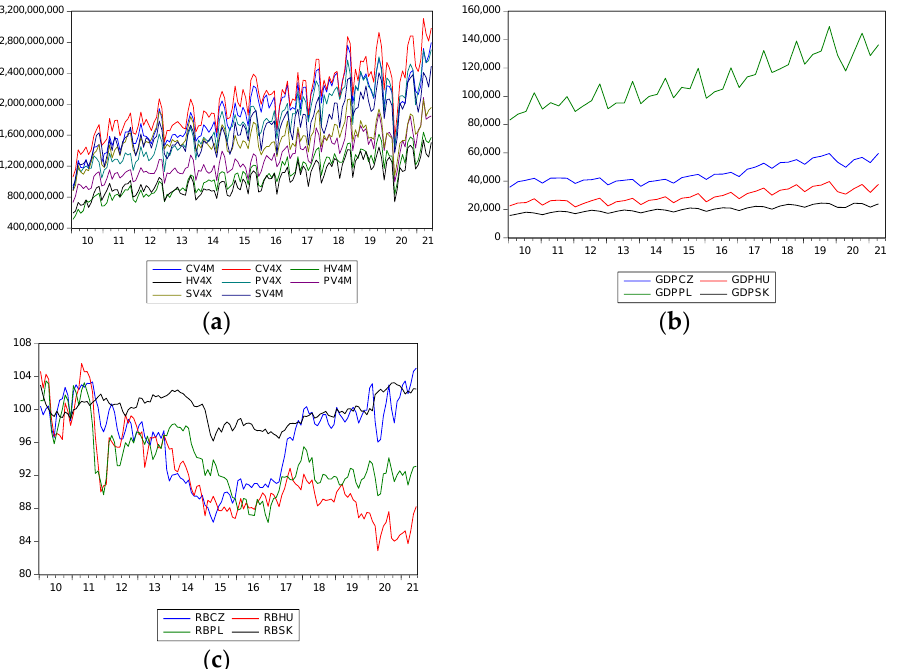
Figure 4. Development of imports, exports, GDP, and real exchange rates of the V4 countries from 2010 to 2021. ( a ) Imports and exports; ( b ) GDP; ( c ) real exchange rates.